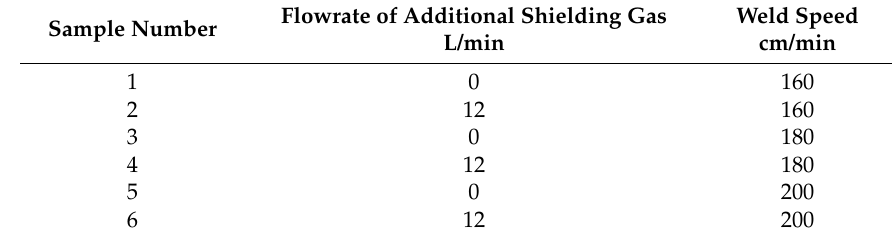
Table 2. Main processing parameters of weld process.